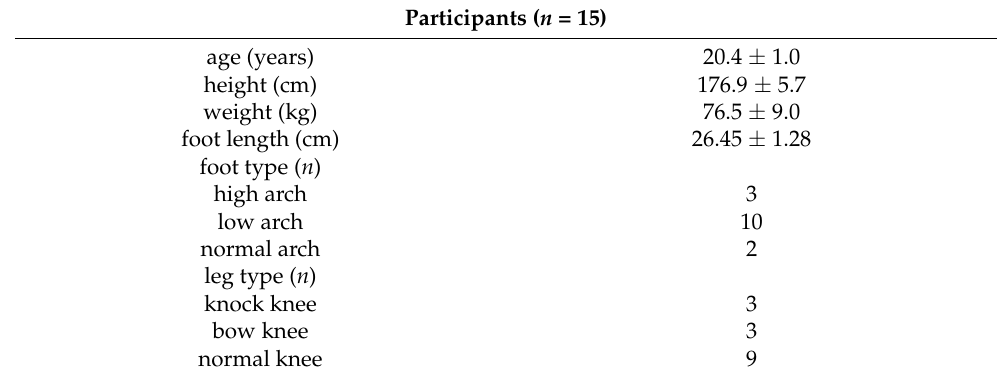
Table 1. Participants’ characteristics.